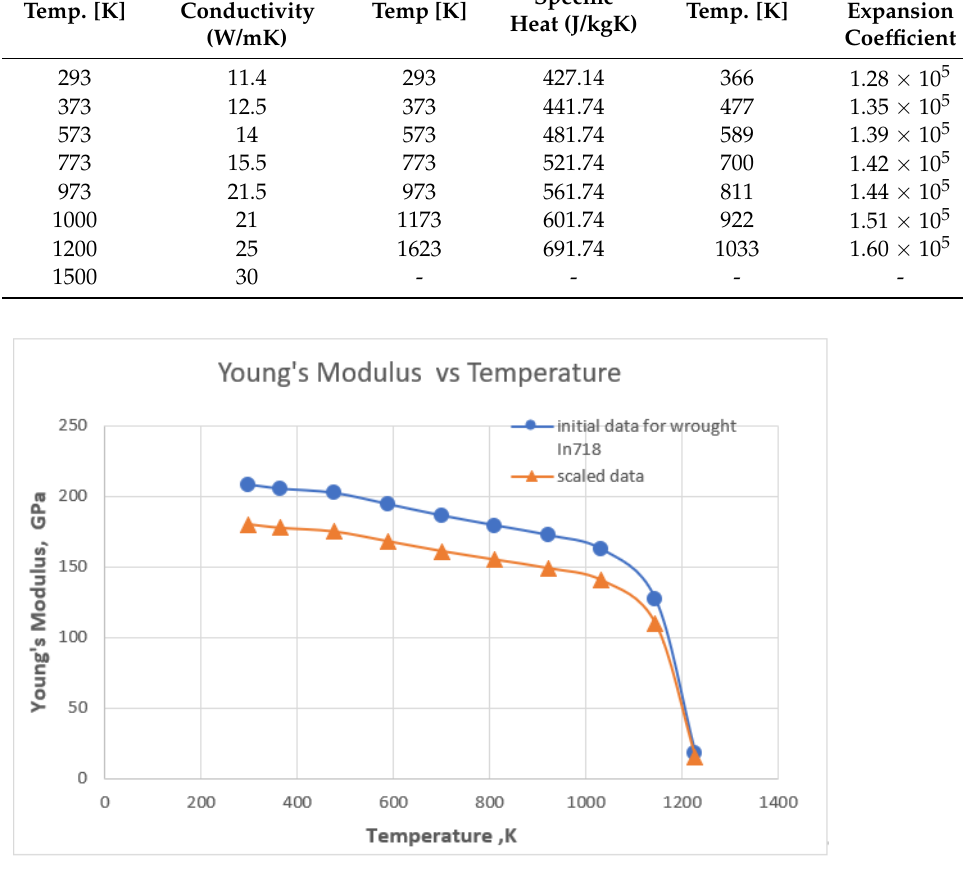
Figure 2. Initial and scaled temperature-dependent Young Modulus.